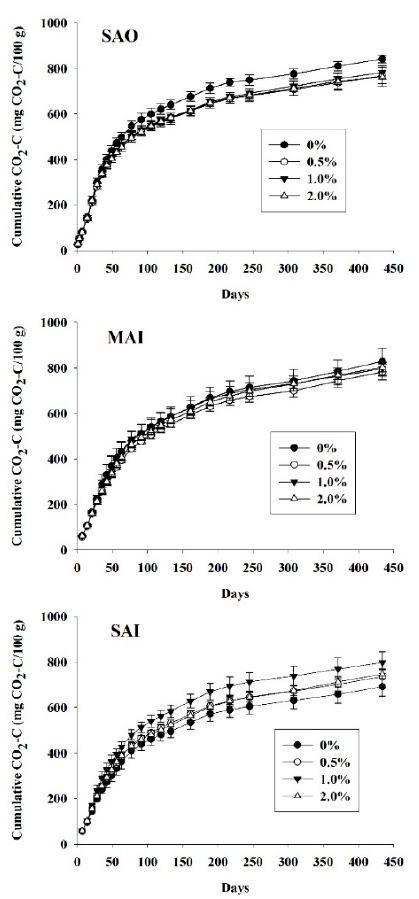
Figure 1. Cumulative CO 2 -C (mg CO 2 -C / 100 g soil) from the three studied soils treated with 0%, 0.5%, 1.0%, and 2.0% woody biochar. Error bars indicated standard deviation of the mean. Table 2. CO 2 -C evolved (mg C/100 g dry weight) and total mineralization coefficient (TMC) for control and amended soils after the incubation experiment 1 .